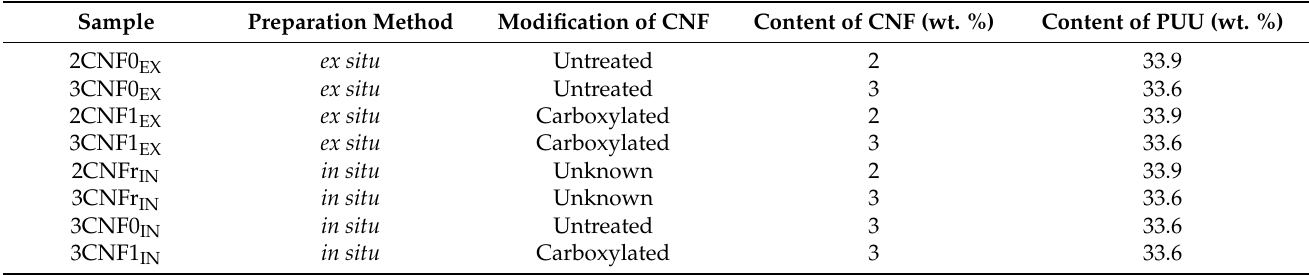
Table 1. Composition of WBPUU/CNF inks.